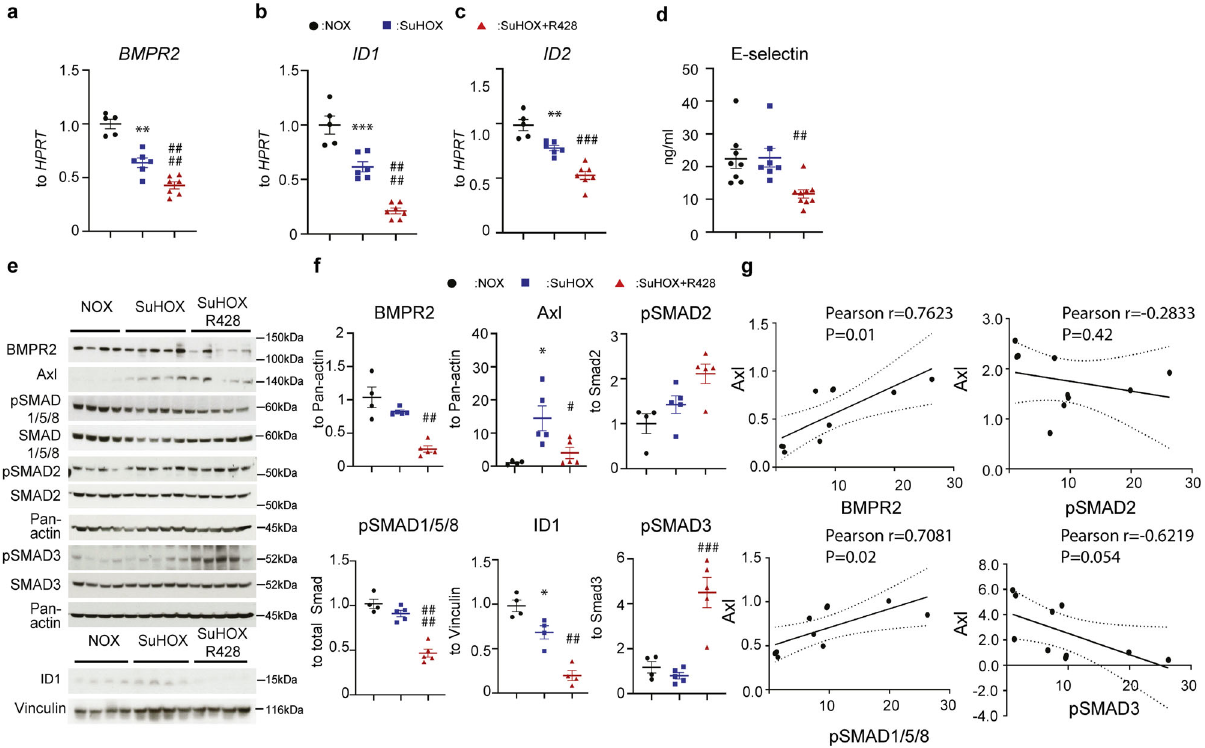
Fig. 5 Effect of R428 on BMPR2 signaling pathway in the Sugen 5416/hypoxia (SuHOX) experimental rat model of pulmonary hypertension. a – c Real- time quantitative PCR analysis of bone morphogenetic protein receptor 2 ( BMPR2 ) and inhibitor of DNA binding 1 ( ID1 ) and 2 ( ID2 ) mRNA expression. Data are presented as the n -fold change (2 − ΔΔ Ct ) normalized to hypoxanthine guanine phosphoribosyl transferase ( Hprt ) as a reference gene, compared with normoxic control rats (normoxic [NOX], n = 5; SuHOX + placebo [SuHOX], n = 6; SuHOX + R428, n = 7 biological independent animals). d Enzyme- linked immunosorbent assays for analysis of the presence of E-selectin in plasma of biological independent rats (NOX, n = 8; SuHOX, n = 7; SuHOX + R428, n = 9 biological independent animals). e Western blots and f subsequent densitometric quanti fi cation of BMPR2, Axl, phospho-SMAD1/ 5/8, phospho-SMAD2, phospho-SMAD3, and ID1 expression in lung homogenates of representative samples from all three studied groups (NOX, n = 4; SuHOX, n = 4-5; SuHOX + R428, n = 4 – 5 biological independent animals). Vinculin and Pan-actin served as a loading controls. g Analyses of the correlation between BMPR2, pSMAD1/5/8, pSMAD2, pSMAD3, and Axl expression in total lungs of rats from SuHOX experimental model. Pearson correlation coef fi cient ( r value) and the signi fi cance (two-tailed P value) of each correlation analysis are represented. Black circles NOX controls; blue squares SUHOX; red triangles SuHOX + R428. Statistical analysis was performed using one-way ANOVA with Tukey ’ s post hoc test for multiple comparisons. * P < 0.05, ** P < 0.01, and *** P < 0.001 for SuHOX versus NOX; # P < 0.05, ## P < 0.01, ### P < 0.001, and #### P < 0.0001 for SuHOX + R428 versus SuHOX. All the data represent the mean ±